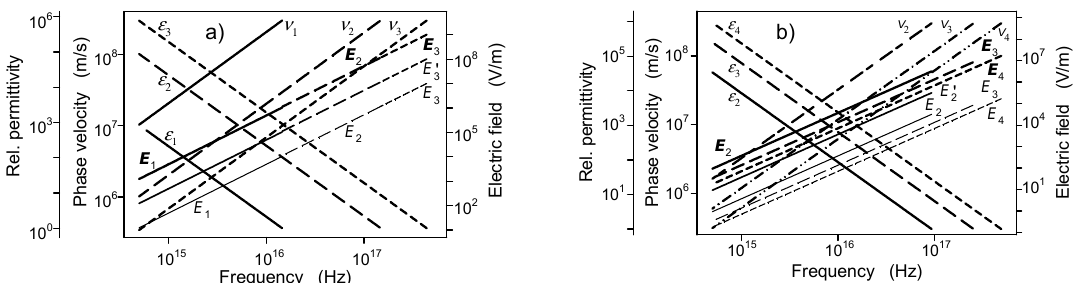
Figure 3. Intensity of the electric component of the electromagnetic field propagating in the lattice B, phase velocity and relative permittivity as a function of frequency. ( a ) is evaluated for propagation along the helix and ( b ) along the axis. The number of oscillation periods along the periodic distance of the helix is 1, 2 and 3 ( a ) and of the axis 2, 3 and 4 ( b ). Coherent signal can be also generated at higher frequencies, e.g., for 10 oscillation periods along the axis the frequency is 6.535 × 10 18 Hz. The thick and the thin lines (the thick and the normal description) correspond to dipole moments 5.8 × 10 − 30 and 5.8 × 10 − 32 Cm, respectively (data for the dipole moment 5.8 × 10 − 31 Cm–the medium lines are marked with primed symbols), E –intensity of the electric field projected to the neighboring receiving dipole, ν –phase velocity of propagation corresponding to the assumed phase shift, ε –relative permittivity evaluated from the phase velocity.